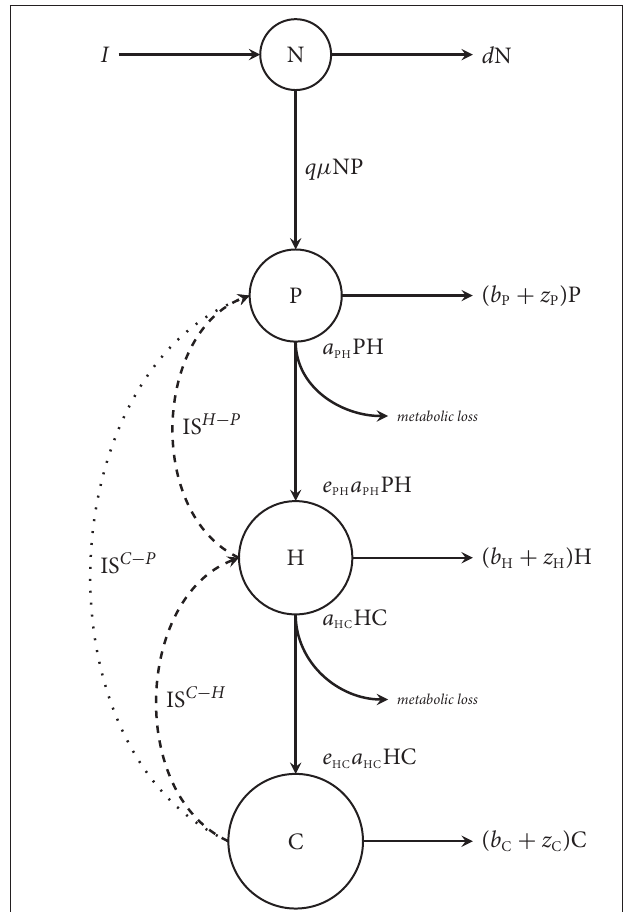
FIGURE 1 | Conceptual diagram of the model. N, P, H and C respectively represent the nutrient, primary producer, herbivore and carnivore variables. Complete arrows stand for fluxes between variables and metabolic losses and dashed arrows correspond to the effects of consumers on resources. IS stands for interaction strength. IS H − P and IS C − H represent the direct interaction between herbivores and primary producers and between carnivores and herbivores, respectively; while IS C − P represents the indirect interaction between carnivores and primary